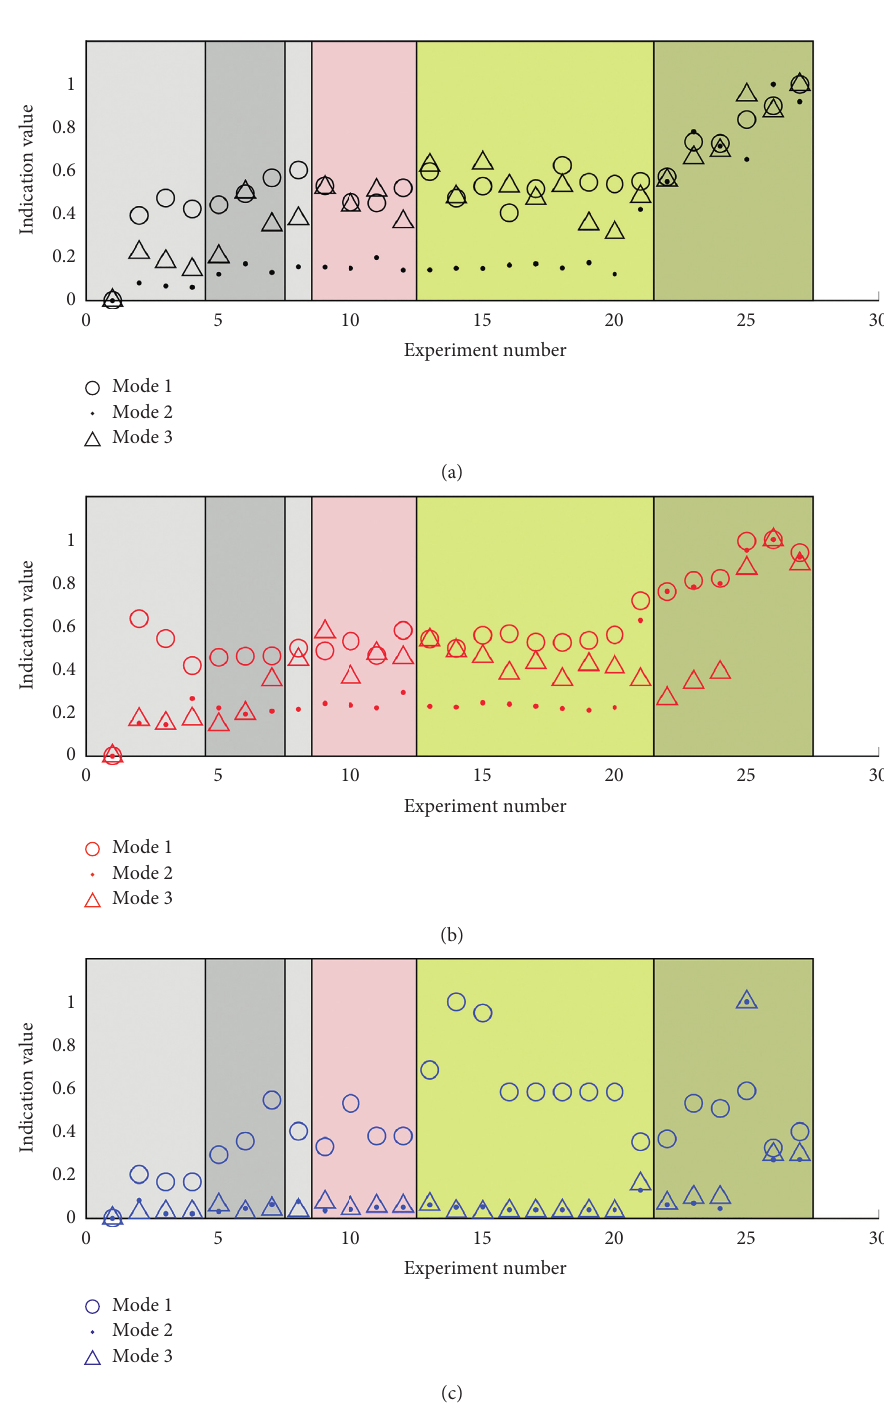
Figure 11: Results of damage detection for the first three modes, for a laboratory experiment, (a) MF method, (b) LMF method, and (c) WV method. Coloring of areas refers to damage scenarios under investigation, with temperature rise marked in dark grey and damage cases 1, 2, and 3 marked with light red, light yellow, and dark yellow, respectively. Values are normalized so each time maximum indication of the given method would equal difference (e.g., measured as RMS of the difference curve) is hidden noise. The example of the above can be seen in slightly higher for the damaged case, there is no clear ”break” Figure 12. Since mode shapes’ differences are not smooth on the surface indicating local nonlinearity or discontinuity. even for an undamaged case, the WV method is hard to use in practice. The smoothness of the MS difference before and after damage introduction is similar. Although the overall